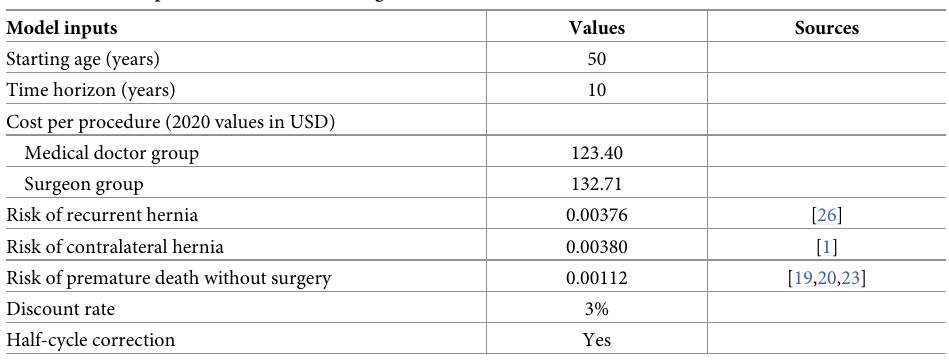
Table 3. Model inputs in the base-case setting.